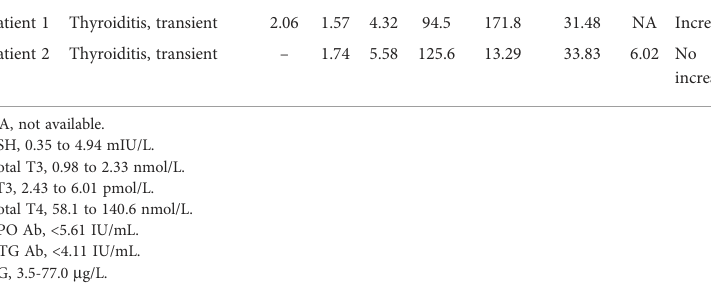
TABLE 2 Dynamic changes of serum cytokines after CAR T cell therapy. Time from CAR T infusion, days